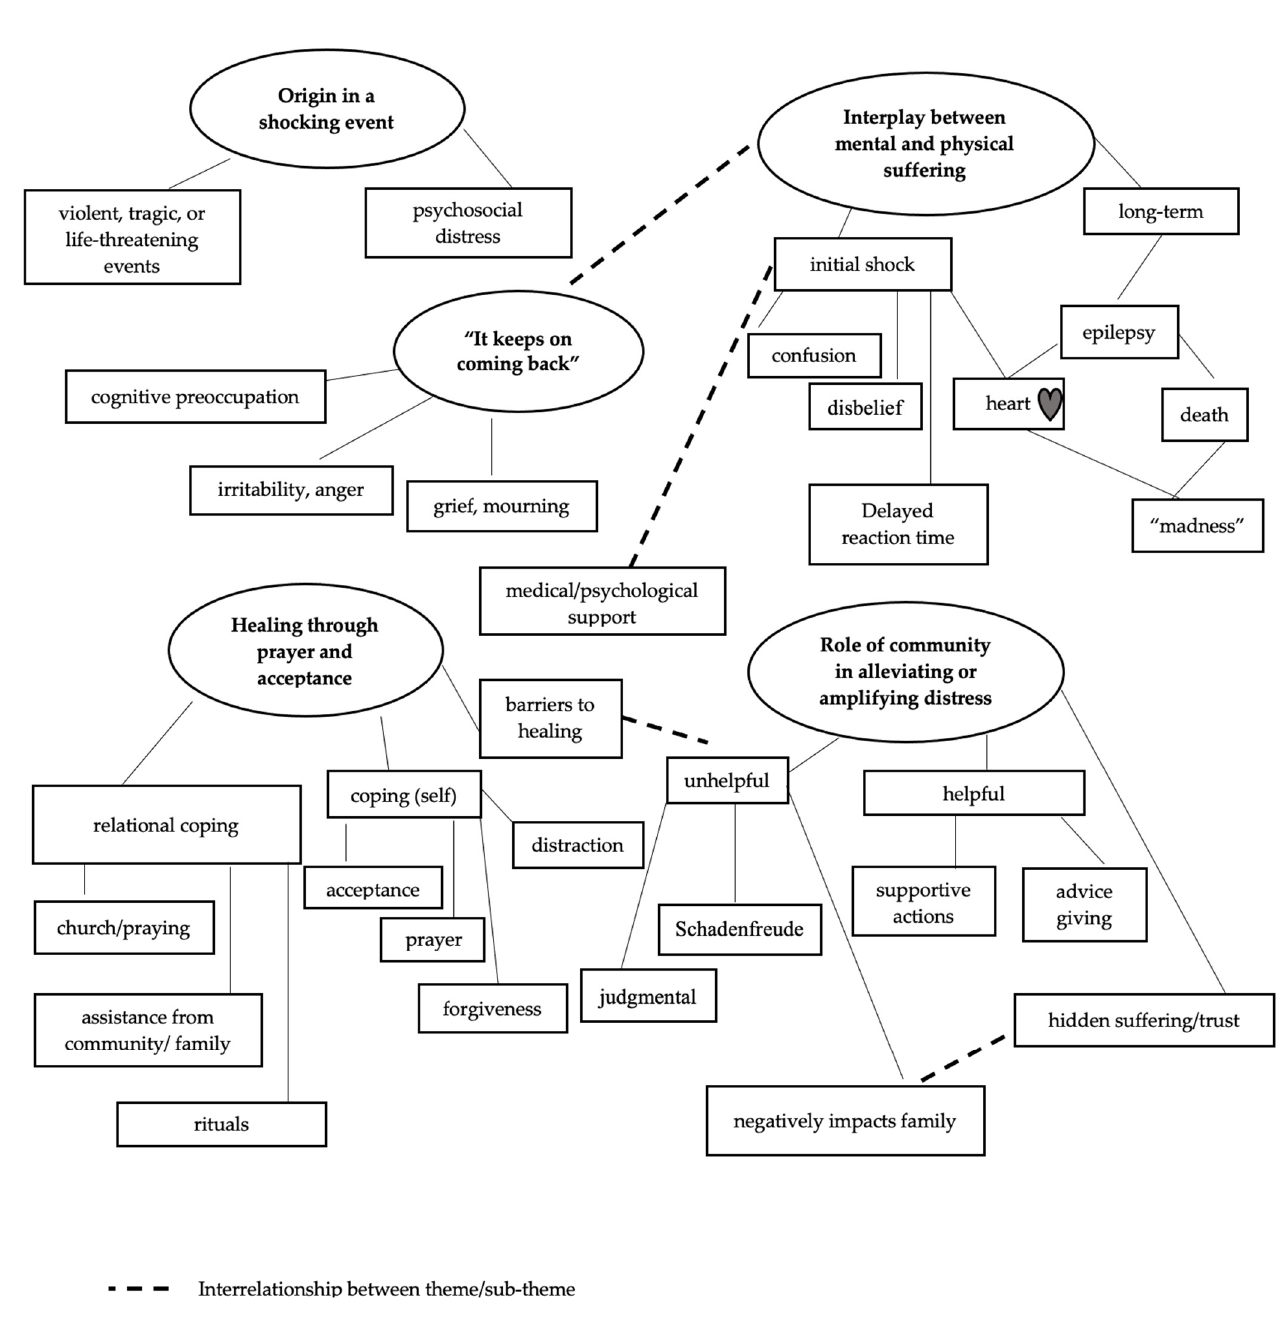
Figure A1. Thematic Map Tsûsa ǃ Nae ǃ khais hâ ǃ nâ/mâ ǃ nâ/ ǂ gâ ǃ nâ.